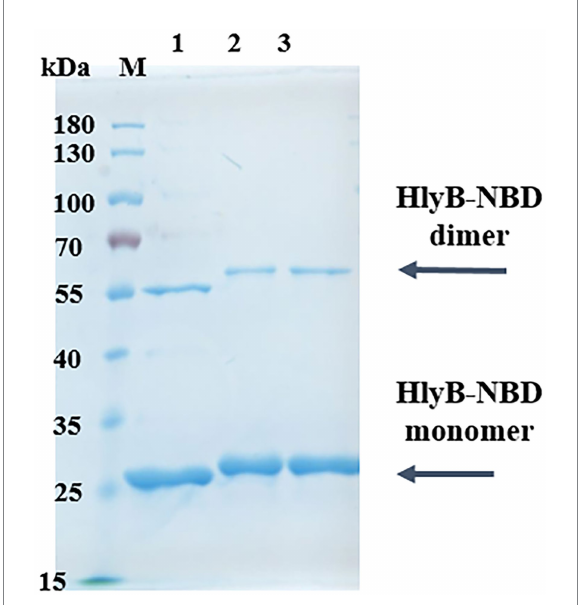
FIGURE 3 Purification of HlyB NBD mutants. SDS-PAGE of purified HlyB NBD of wild type (1), double-pbp-in (2), and (3) triple-pbp-in (3). M, marker proteins; the molecular weight of the marker proteins is given on the left.